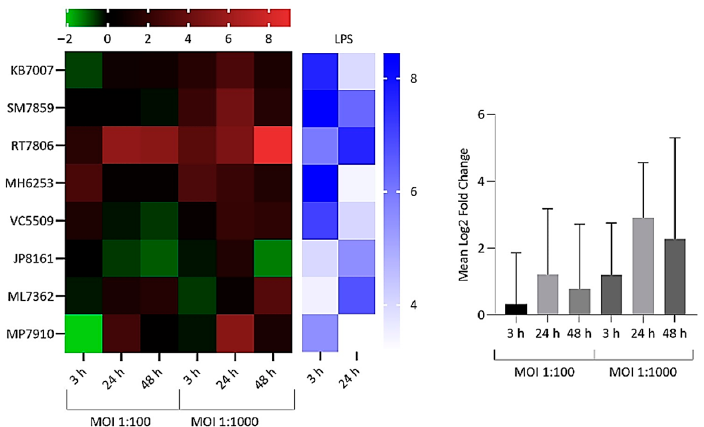
Figure 2. Heatmap and bar chart of log 2 fold gene expression changes for interleukin (IL)-1 β in NP-derived disc cells infected with C. acnes . Heatmap values are individual expression changes (3 × biological replicates) from eight donor samples, while the bar chart represents average donor changes. Results with lipopolysaccharide (LPS)-positive controls are also shown. The top bar represents the log 2 fold-change scale.